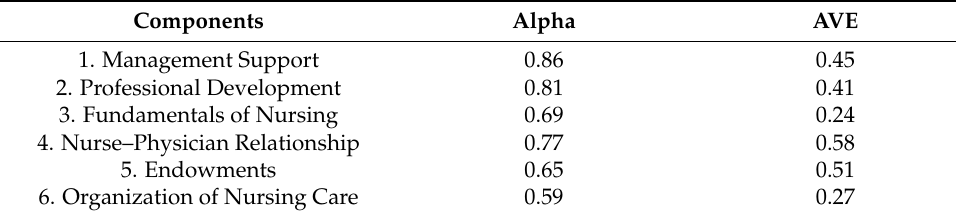
Table 2. Construct validity of the Nursing Work